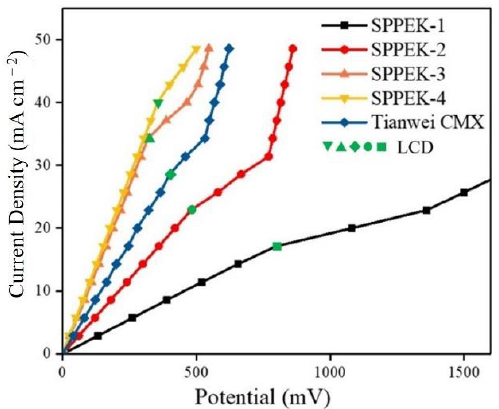
Figure 8. I-V curves of SPPEK membranes and commercial for comparison.